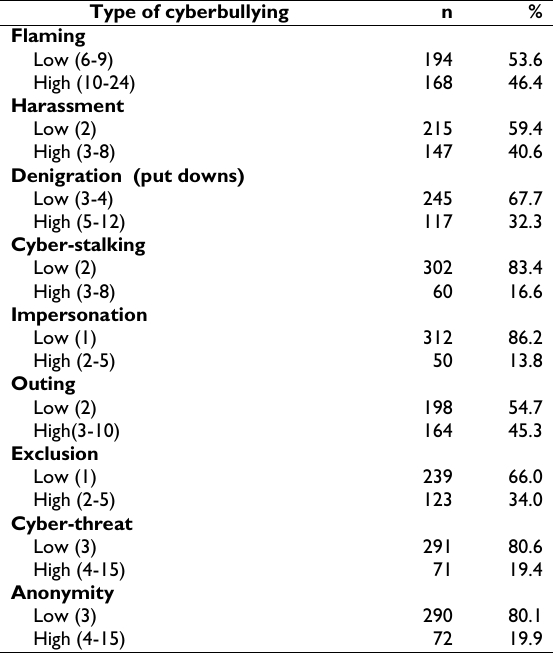
Table 3 The types of cyberbullying behaviors in early adolescence (N = 362) Type of